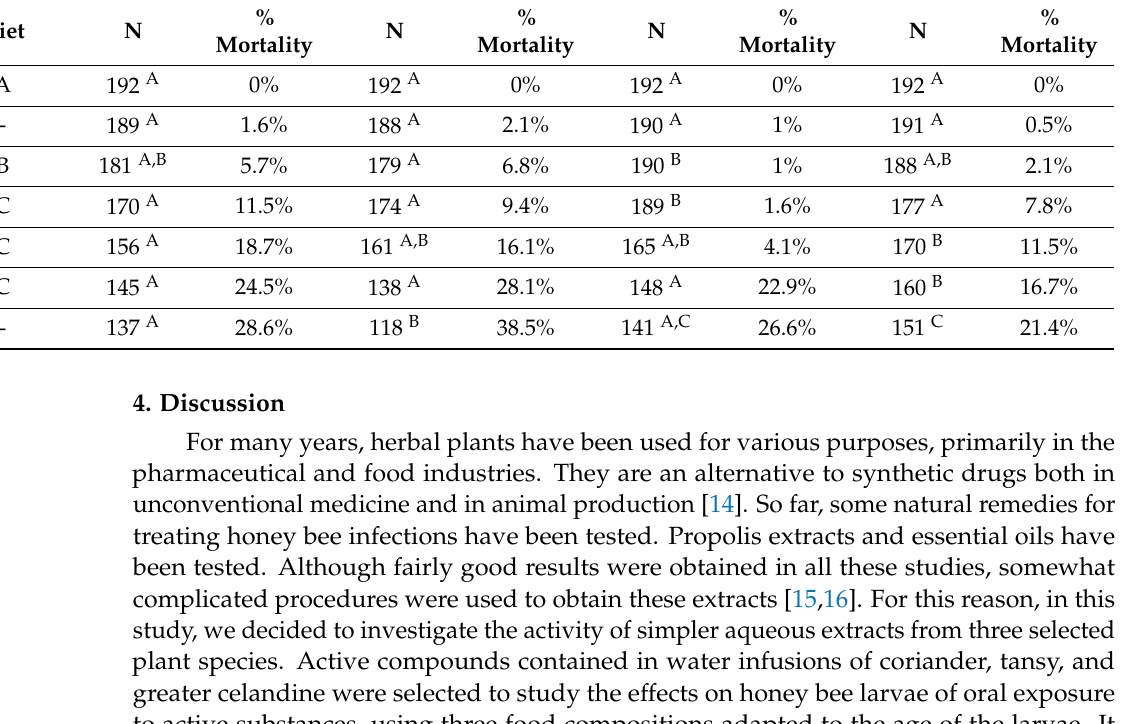
Table 3. Mortality of honey bee larvae fed with three different food compositions (diets A, B, and C), adjusted to the age of larvae and treated with biologically active compounds contained in aqueous infusions of herbs of selected plant species; survival assessment consisted of daily counts of dead larvae; N = number of surviving larvae (total of 192 larvae for each group; 4 repetitions of 48 larvae). Coriander Greater Celandine Tansy Control C. Sativum C. Majus T. Vulgare % % N N N Mortality Mortality